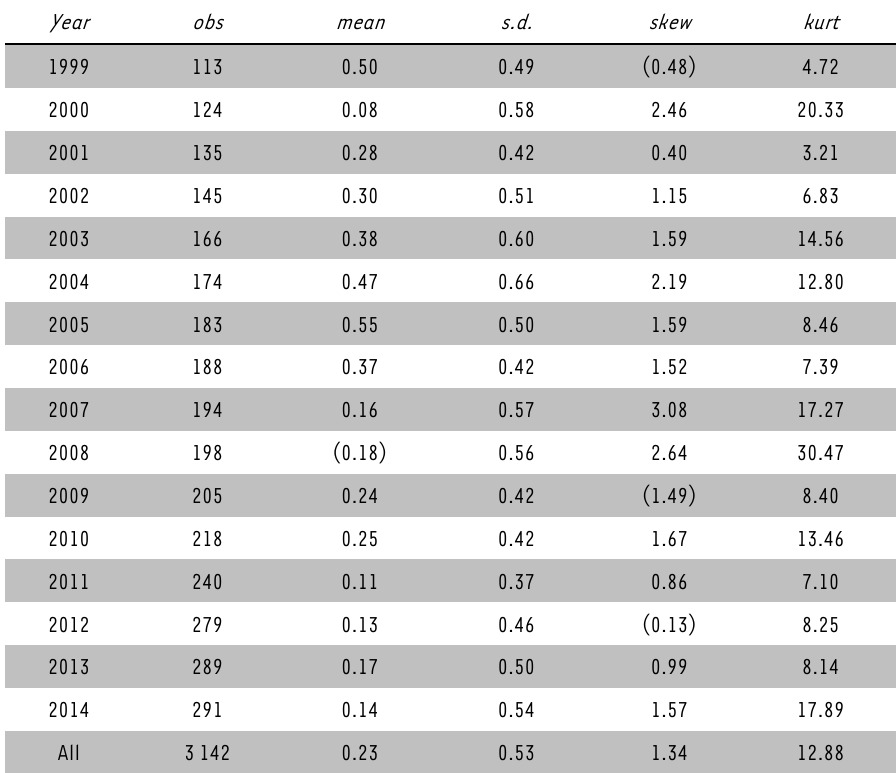
TABLE A-1: Analysis of mean returns skewness and